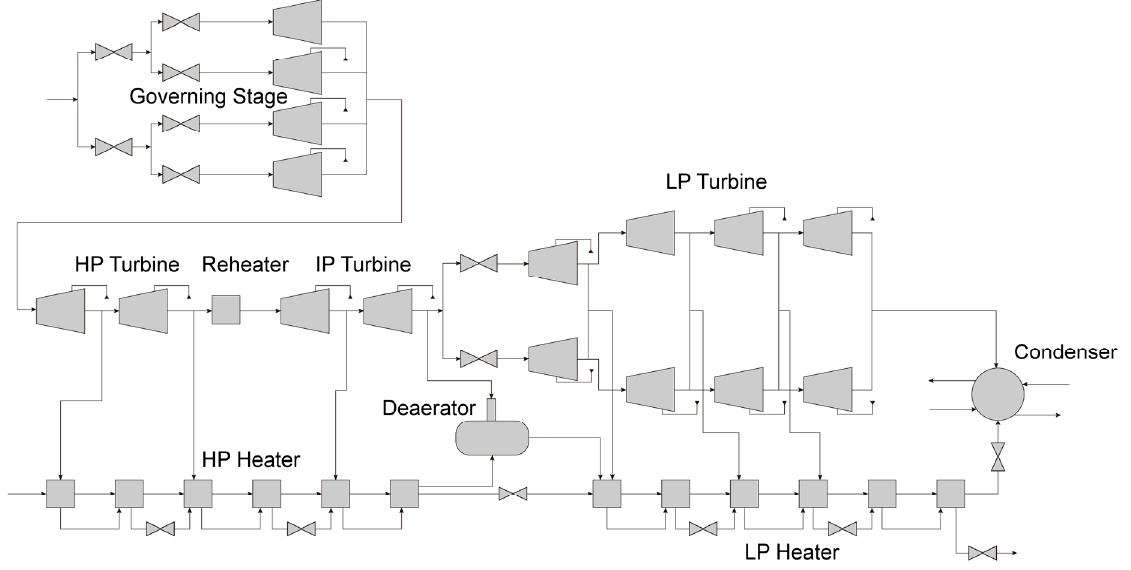
Figure 7. Schematic diagram of the steam turbine.